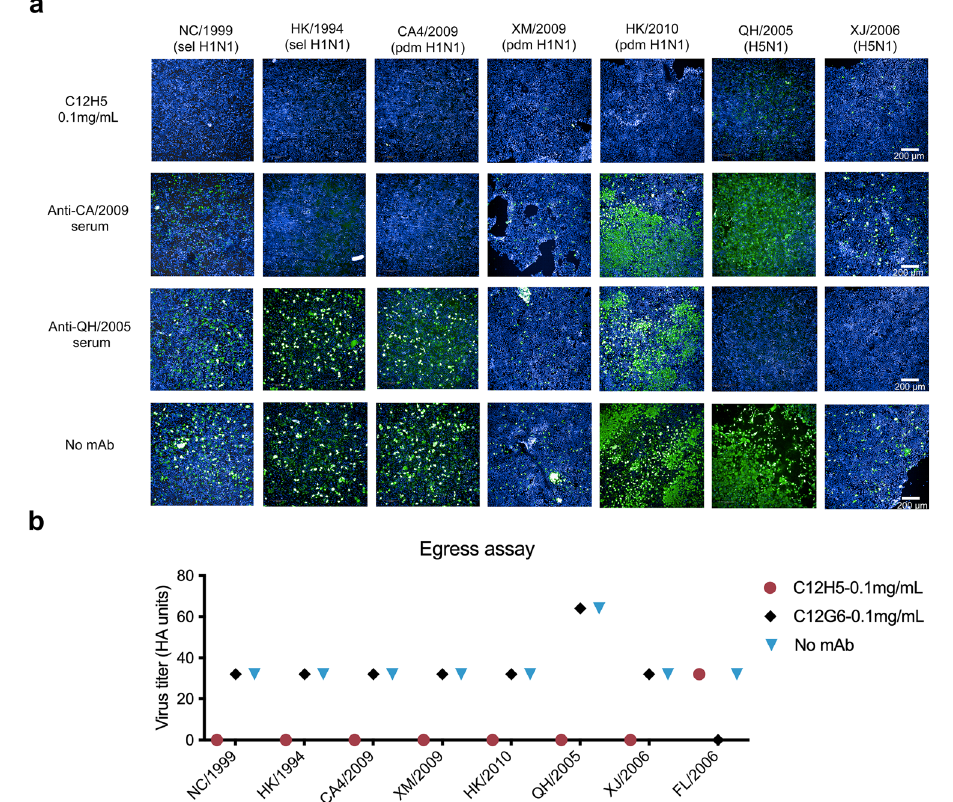
Fig. 4 | Neutralization mechanism of C12H5. a MDCK cells were inoculated with NC/1999, HK/1994, CA4/2009, XM/2009, HK/2010, QH/2005 or XJ/2006 viruses pre-incubated with C12H5 or polyclonal rabbit sera. The expression of in fl uenza A virus nucleoprotein in MDCK cell monolayers at 16 to 18h after inoculation was detected by immuno fl uorescence. Green, infected cells positive for NP protein; blue, 4 ′ ,6-diamidino-2-phenylindole staining. b Egress assay of in fl uenza A